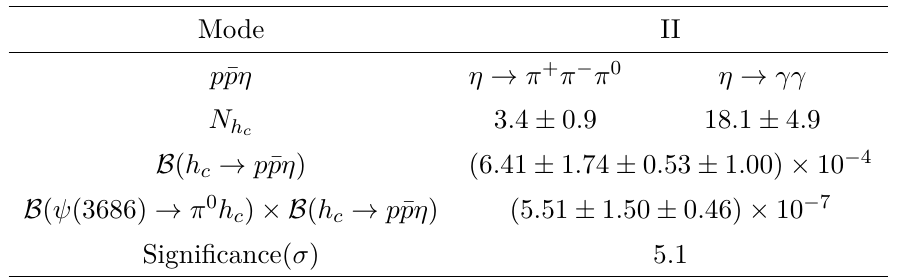
, the absolute branching fraction B ( h c ) × B ( h ¯ pη ) , and the statistical significance, c c → p